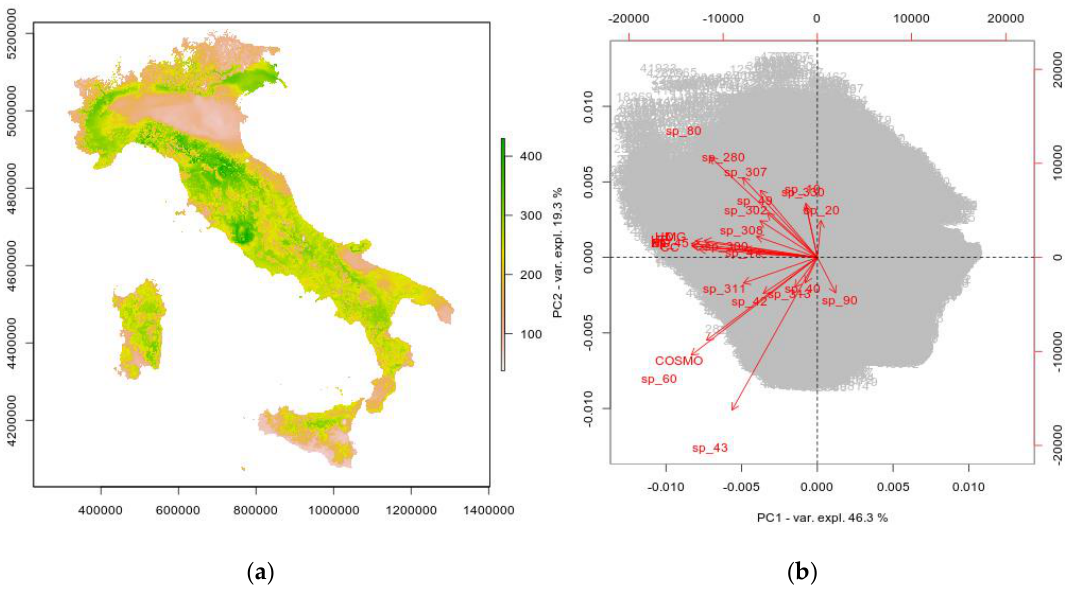
Figure 2. ( a ) Spatial pattern of the standard deviation of the LS difference between future (2050s) and current (1981–2010) values for each species and using all the future climate realizations (133 layers) and ( b ) PCA analysis run on the same data (i.e., LS variation at pixels level).